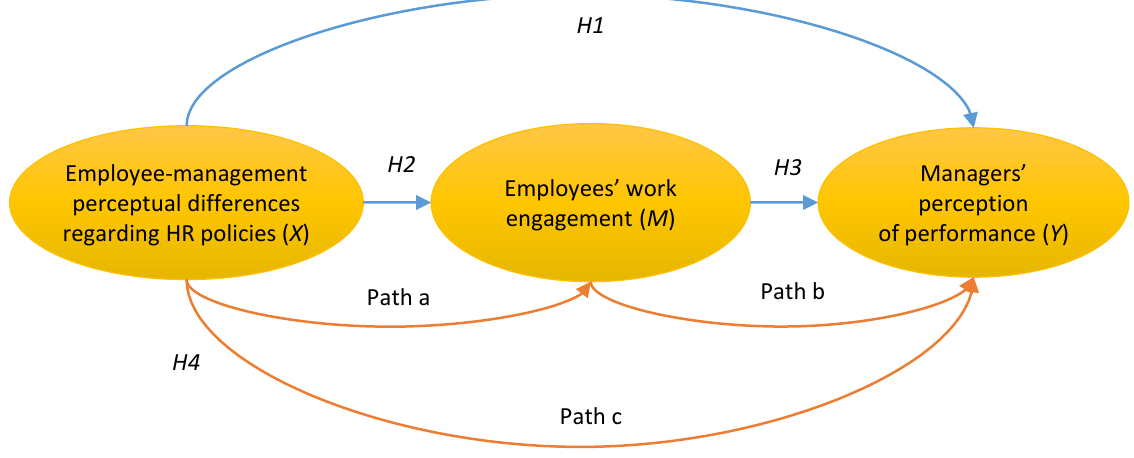
Figure 1. Research